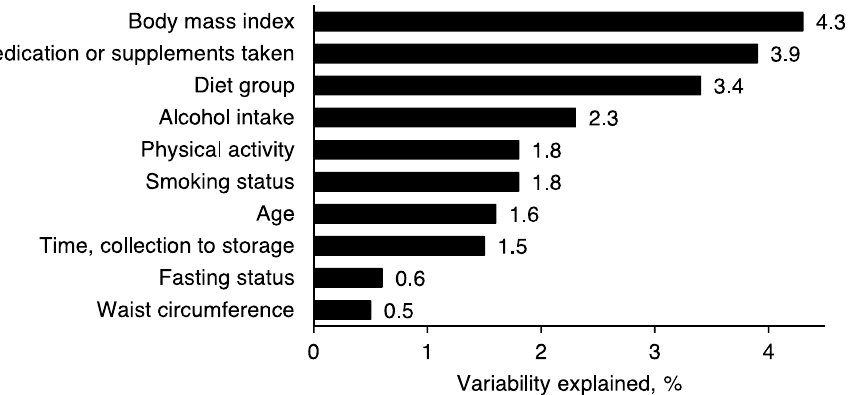
Figure 1. Variability in NMR metabolite data explained by diet group and other covariates. The percentage of the total variability explained by each variable was calculated using the Principal Component Partial R-square (PC-PR2) method [32], which accounts for all variables in the model.